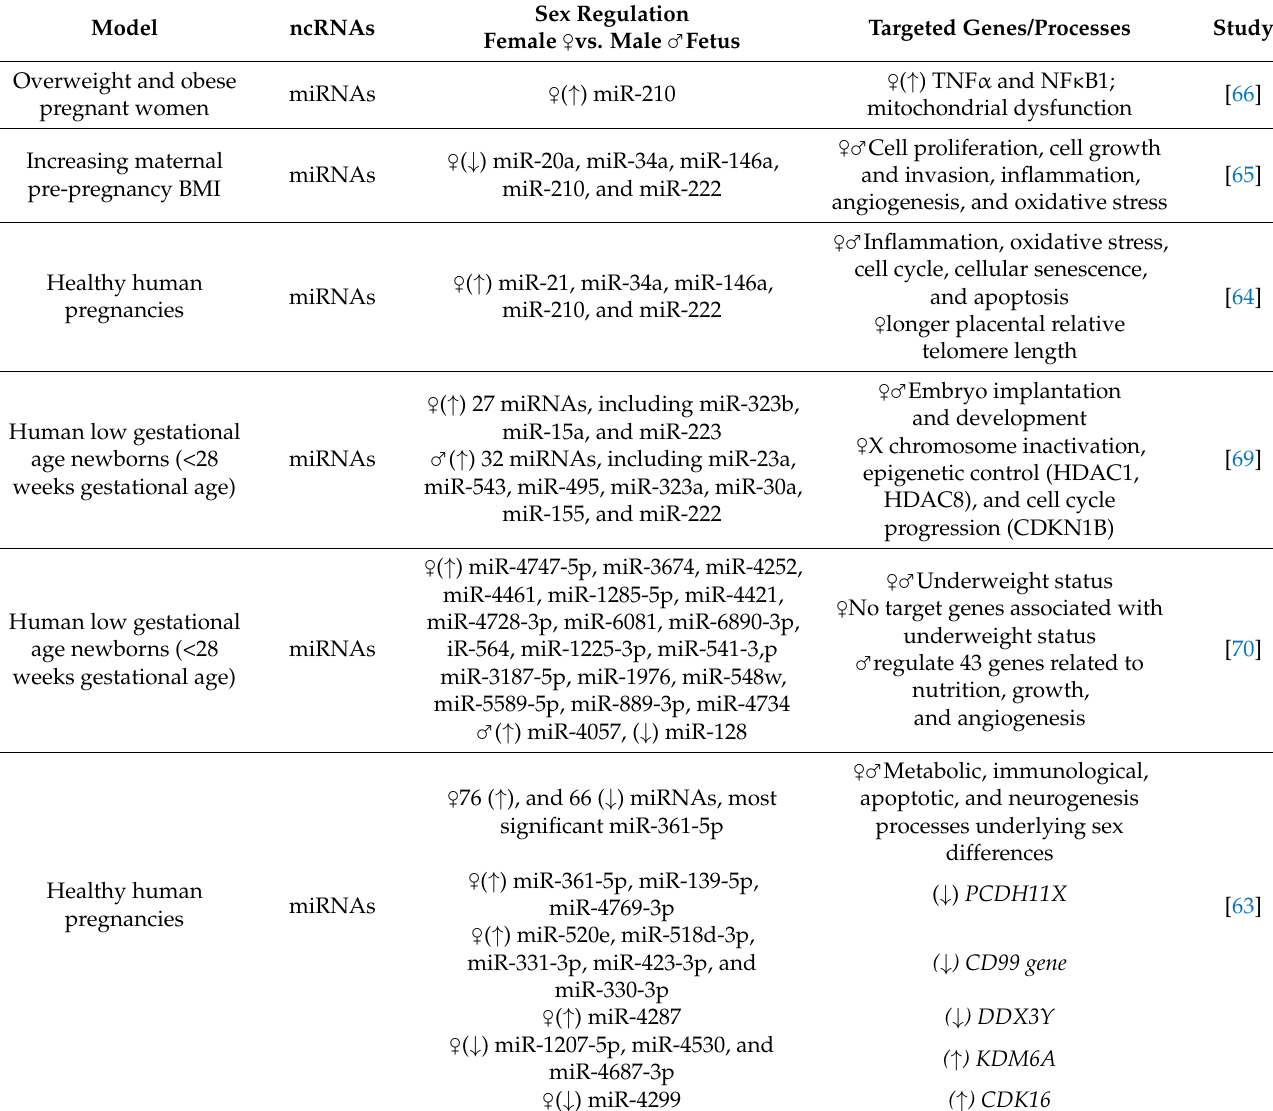
Table 1. Sex-specific ncRNAs expression in